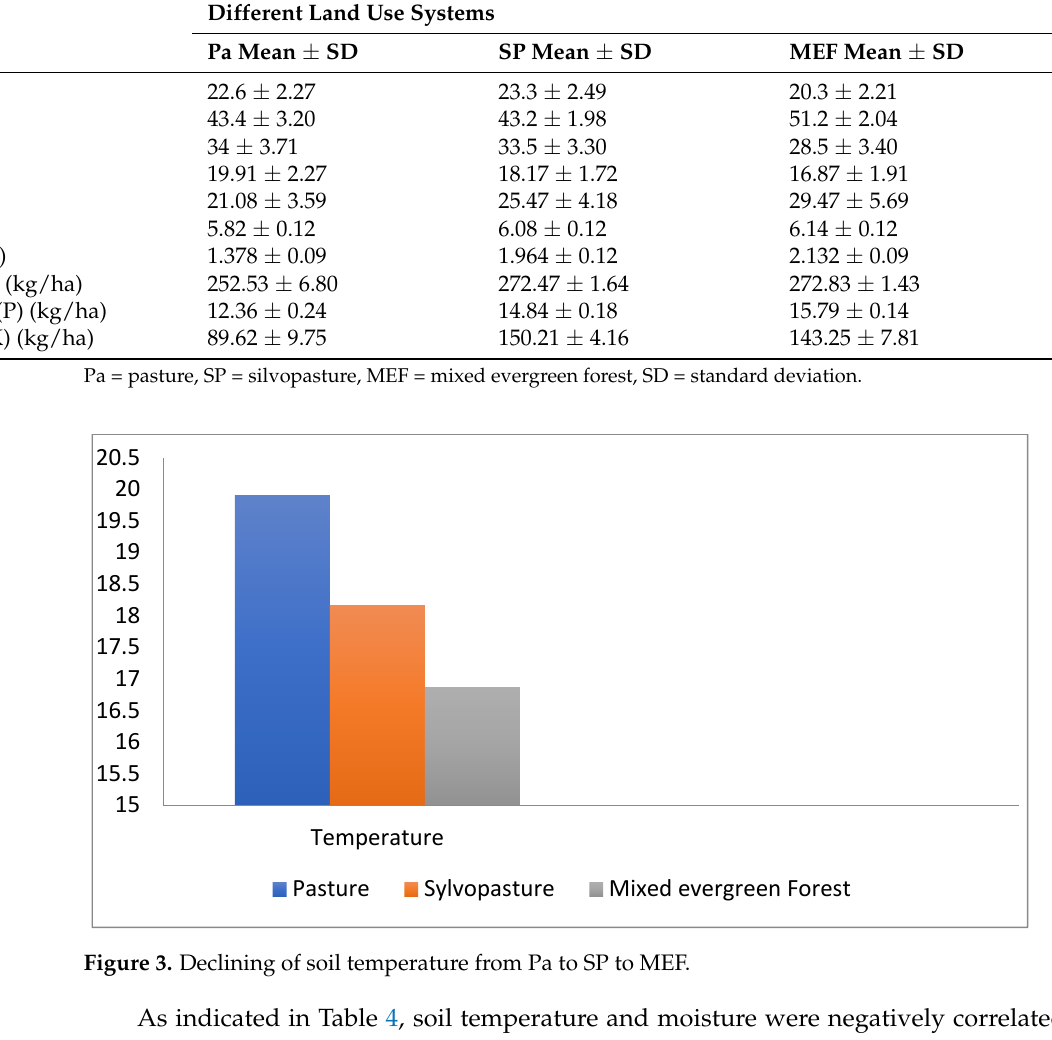
Figure 4. Declining of soil moisture from MEF to SP to Pa. The two-way ANOVA output showed that the variation in organic carbon (C) con- centration, potassium (K), phosphorus (P), and nitrogen (N) between land use systems were statistically significant at p < 0.0001. The variation in soil nutrients (C, K, and P) be- tween seasons was also statistically significant ( p < 0.005) except for N ( p < 0.5) (Table 5). Table 5. The two-way ANOVA result of soil nutrients (C, K, P, and N). Nutrients